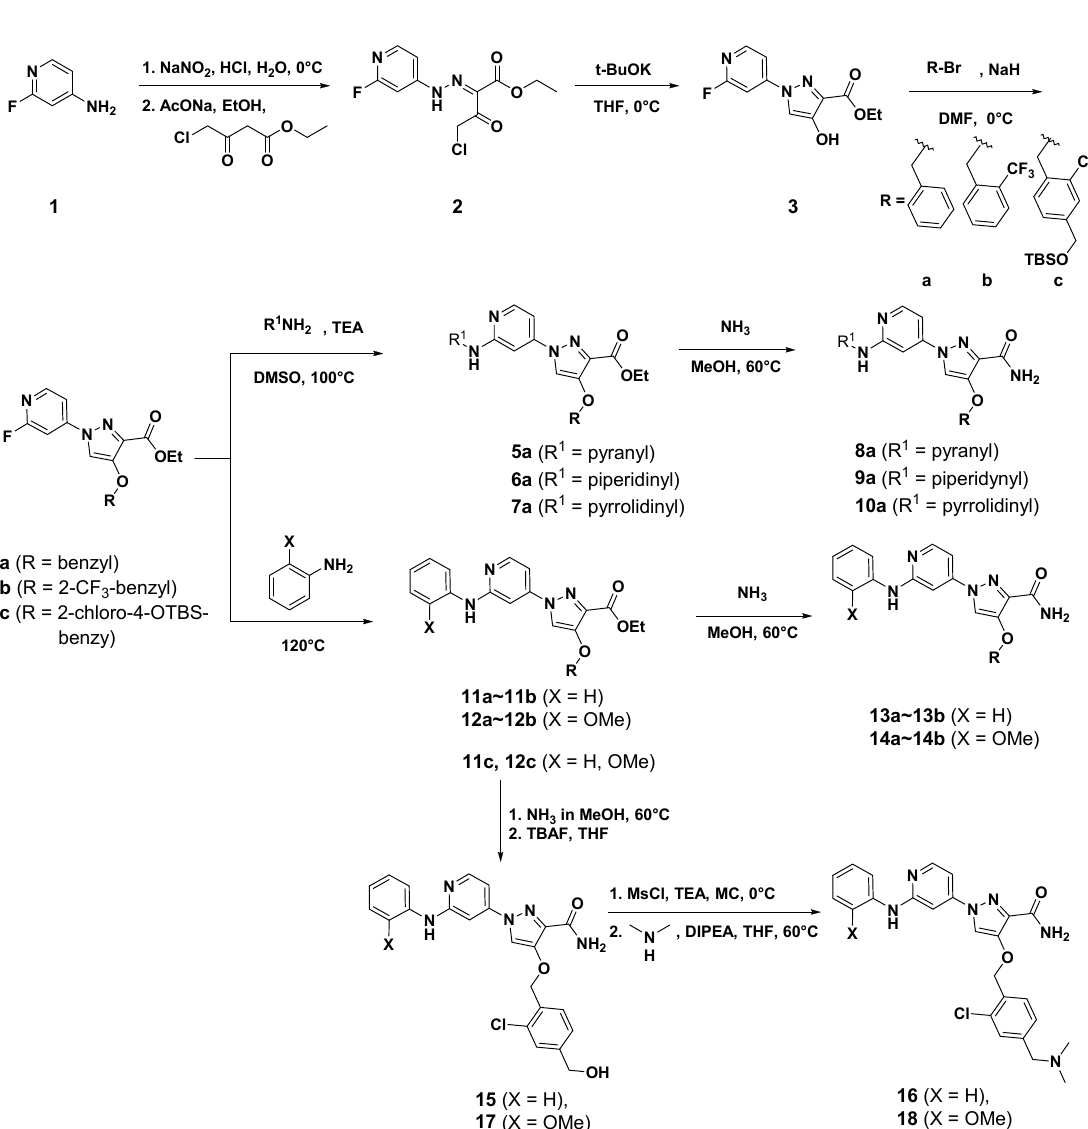
Scheme 1. Synthesis of 4-((2-R 2 -4-R 3 -benzyloxy)-1-(2-(2-R 1 -amino)pyridin-4-yl)-1 H -pyrazole-3-carboxamide.